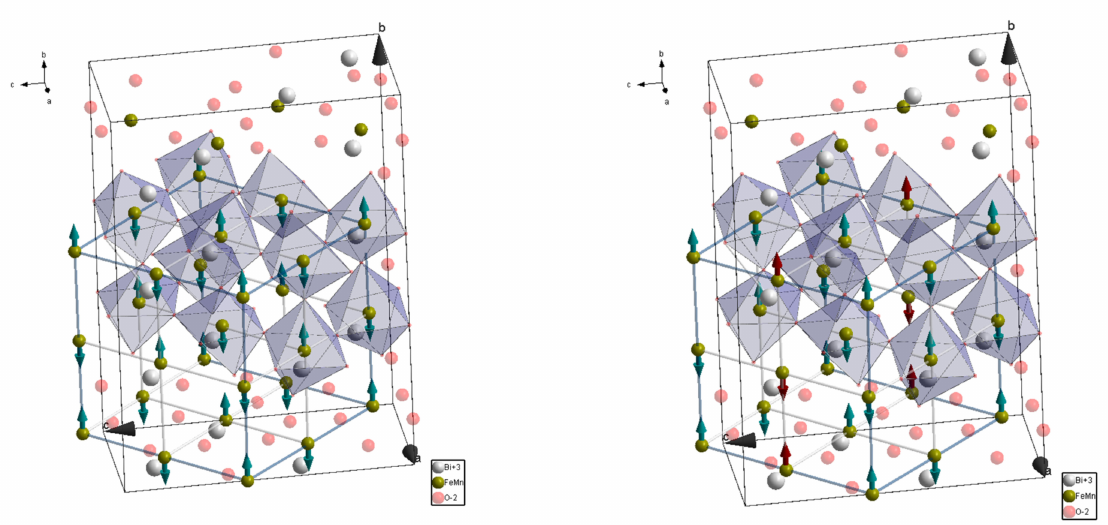
Figure 5. Schematic presentation of the orthorhombic lattice; the alignment of the magnetic moments are marked by the arrows, before thermal annelaing at 700 K— left image, and after— right